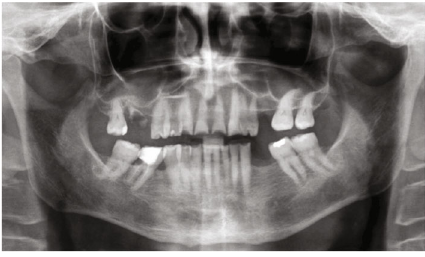
Figure 6: The panoramic radiograph showing the lateral incisor agenesis.